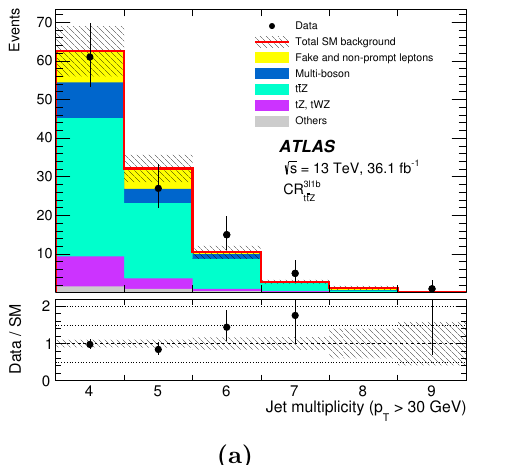
and (b) CR 3 ‘ 1 b , after normal- V V t (cid:22) tZ